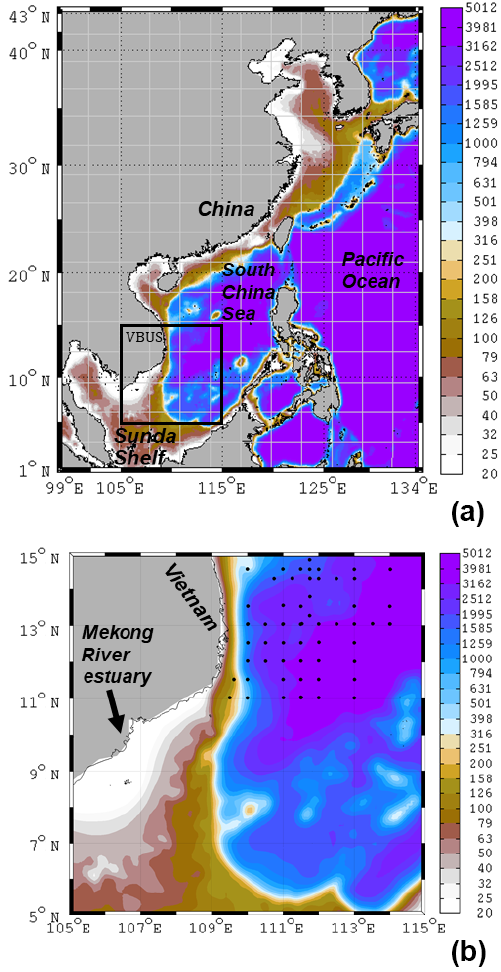
Figure 1. (a) Model domain and the bathymetry (unit: m) for the Taiwan Strait Nowcast/Forecast system and carbon, silicon, ni- trogen ecosystem (TFOR-CoSINE) model. Model grid nodes are shown every 25 points. The study area VBUS is boxed. (b) Zoom- in area of VBUS. Black diamonds are the observation stations (see